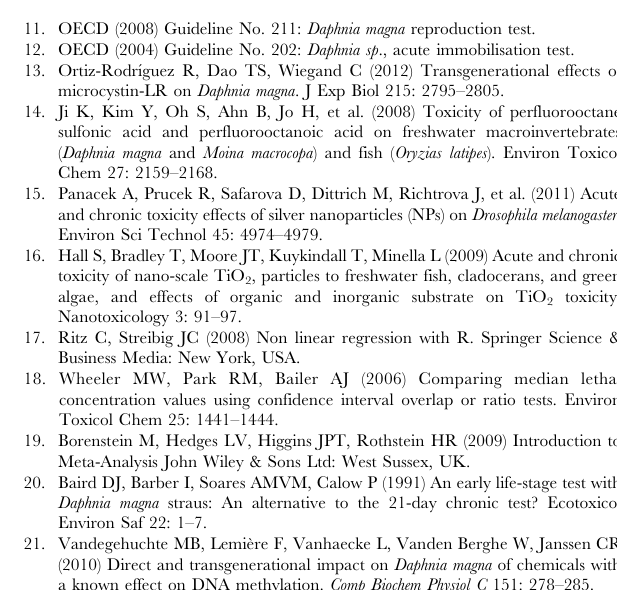
Figure S1 120 h- EC 50 values with respective 95% CIs of adult D. magna following 18 days of exposure to nTiO 2 (P25) in the flow- through system (fifth set of experiments). No statistically significant deviations regarding the sensitivity were detected. Figure S2 Boxplot (bold line represents the median) of the offspring per test organism (n= 20) exposed to P25 (first set of experiments) or A-100 (fourth set of experiments) nTiO 2 after 21 days of exposure to 0.00, 0.02 or 2.00 mg nTiO 2 /L. Figure S3 96 h-EC 50 values with respective 95% CIs of the fifth brood released by adults exposed to P25 nTiO 2 during the flow- through experiment (first set of experiments); Asterisk (*) denotes statistically significant difference between the juveniles released from adults exposed to 2.00 mg/L TiO 2 and the control based on confidence interval testing (difference between 96 h-EC 50 values 4.39 mg/L, 95% CI 0.62 to 8.15). Figure S4 Lipid content per adult D. magna after 21 days of exposure to P25 nTiO 2 (first set of experiments).